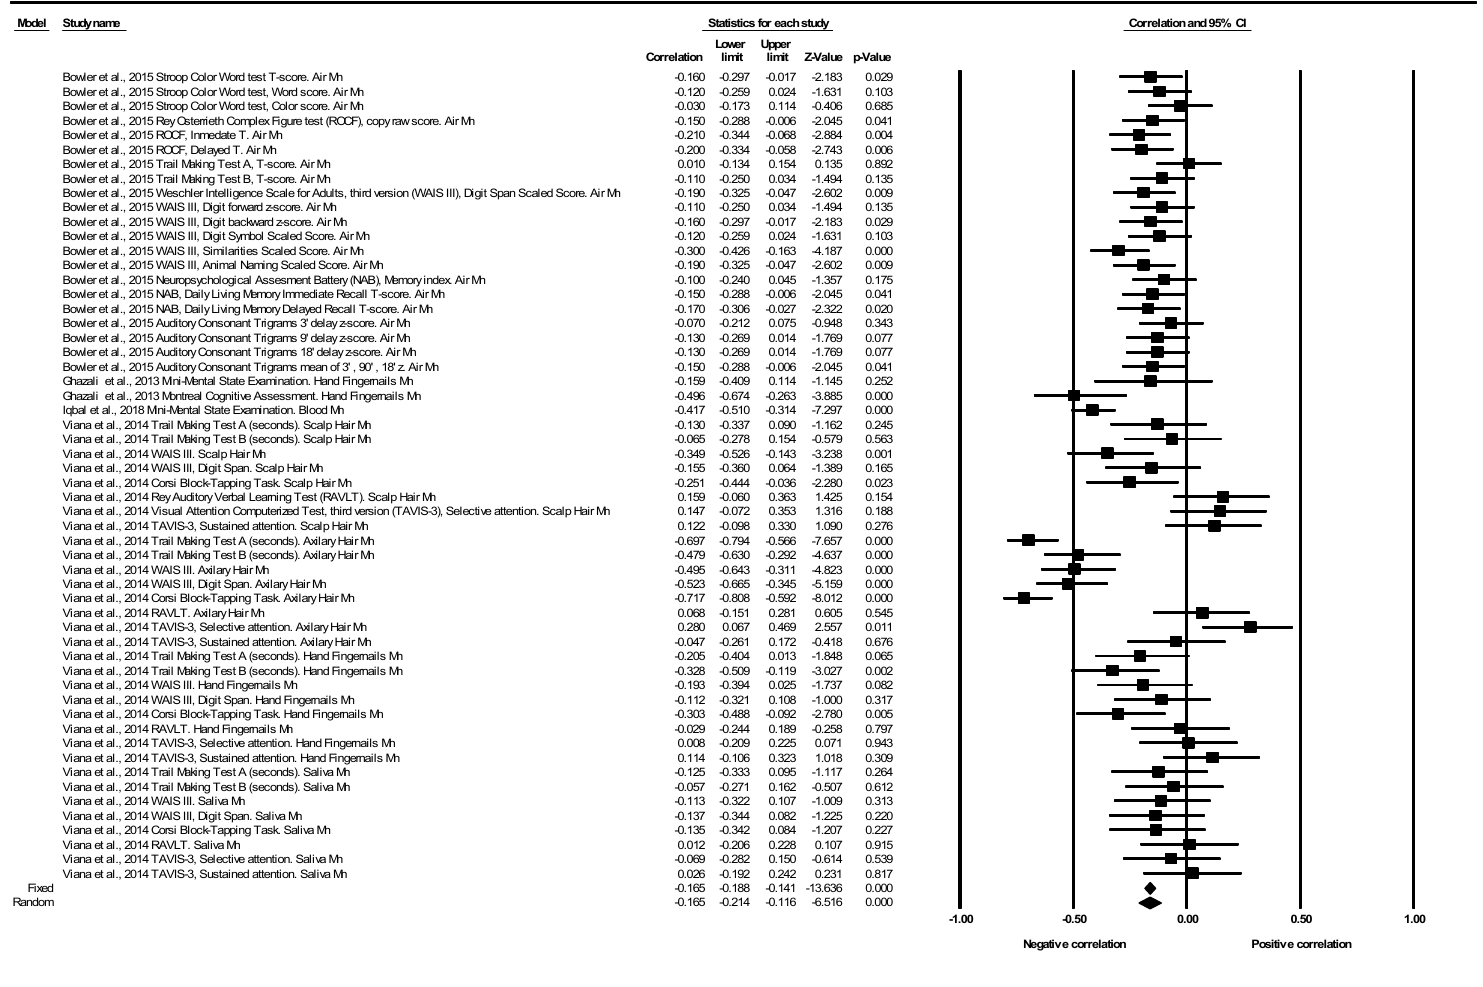
Figure 2. Correlation between cognitive function and exposure to Mn. All tests and all exposures to Mn. Note: a negative correlation indicates that the higher the Mn levels, the worse the cognitive function.